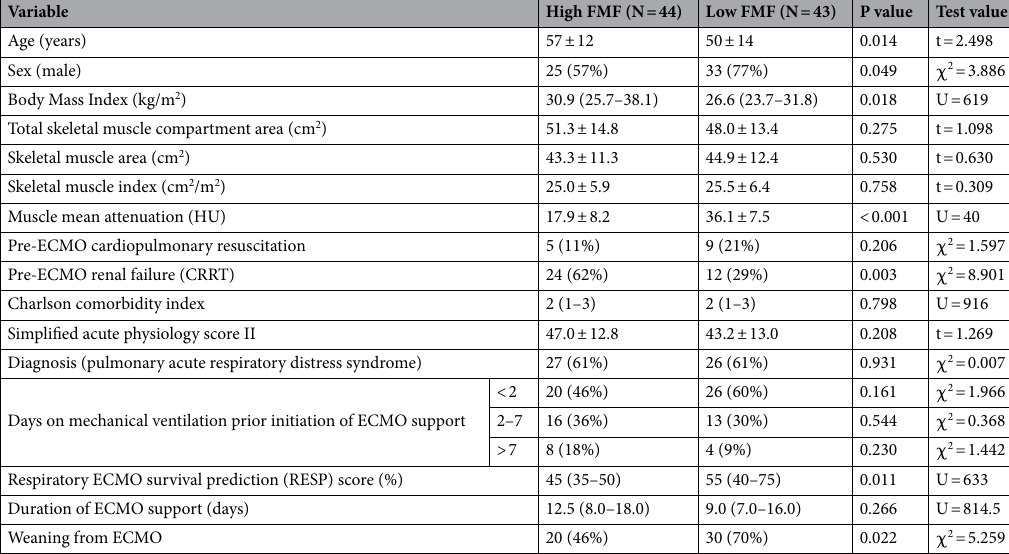
Table 1. Clinical characteristics of the study population. The cohort was binarized into patients with high and low FMF with a cutoff value of > 44% to define high FMF. Continuous variables are expressed as means with standard deviation while categorical variables are given as total counts and percentages. CRRT Continuous Renal Replacement Therapy, ECMO Extracorporal Membrane Oxygenation, FMF Fatty muscle fraction, RESP Respiratory ECMO Survival Prediction Score.